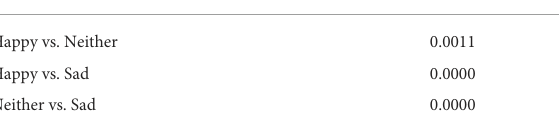
TABLE 10 Significantly different pairs from Tukey test of reported emotion.